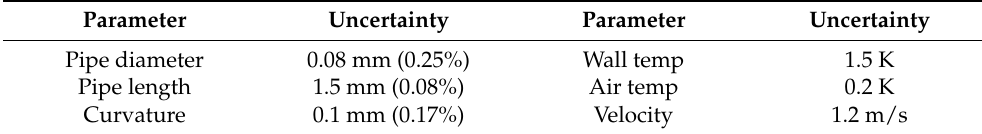
Table 1. Major parameter uncertainties.